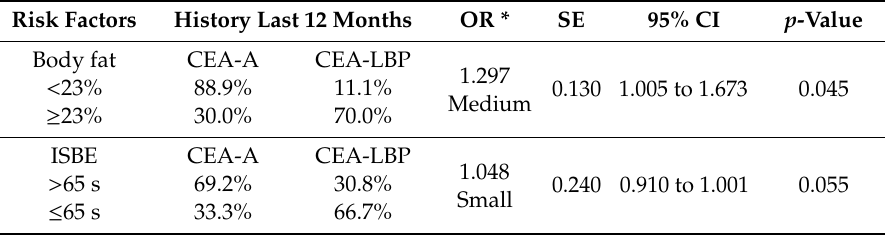
Table 4. Relative frequencies and logistic regression results for lower back pain for the 19 equestrian athletes.